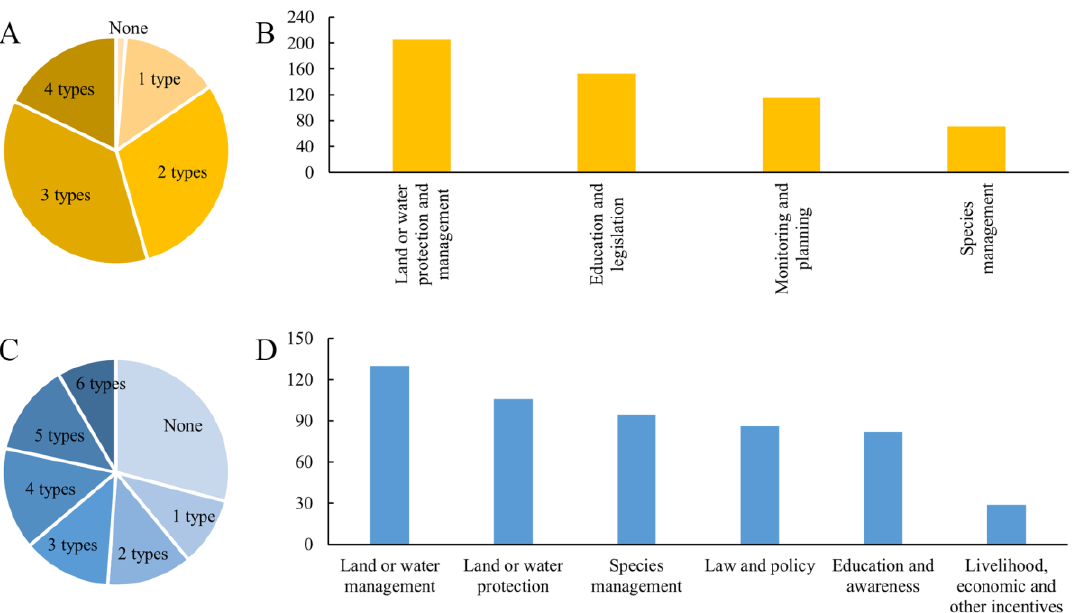
Figure 5. Conservation statuses of the 213 recommended umbrella species: ( A ) the proportions of recommended umbrella species that are currently protected by varying types of conservation actions, and ( B ) the number of species that are under protection for each type of conservation action; ( C ) the proportions of recommended umbrella species that need varying types of conservation actions, and ( D ) the number of species that need each type of conservation action.